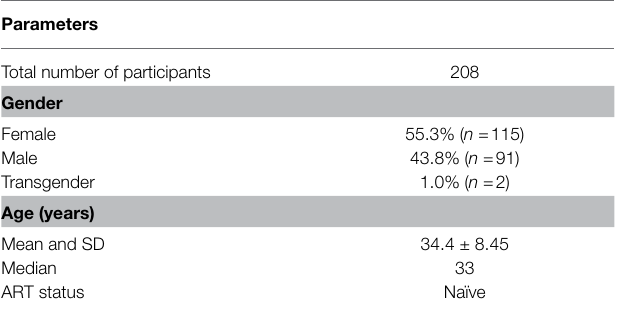
TABLE 2 | Characteristics of study participants at the time of